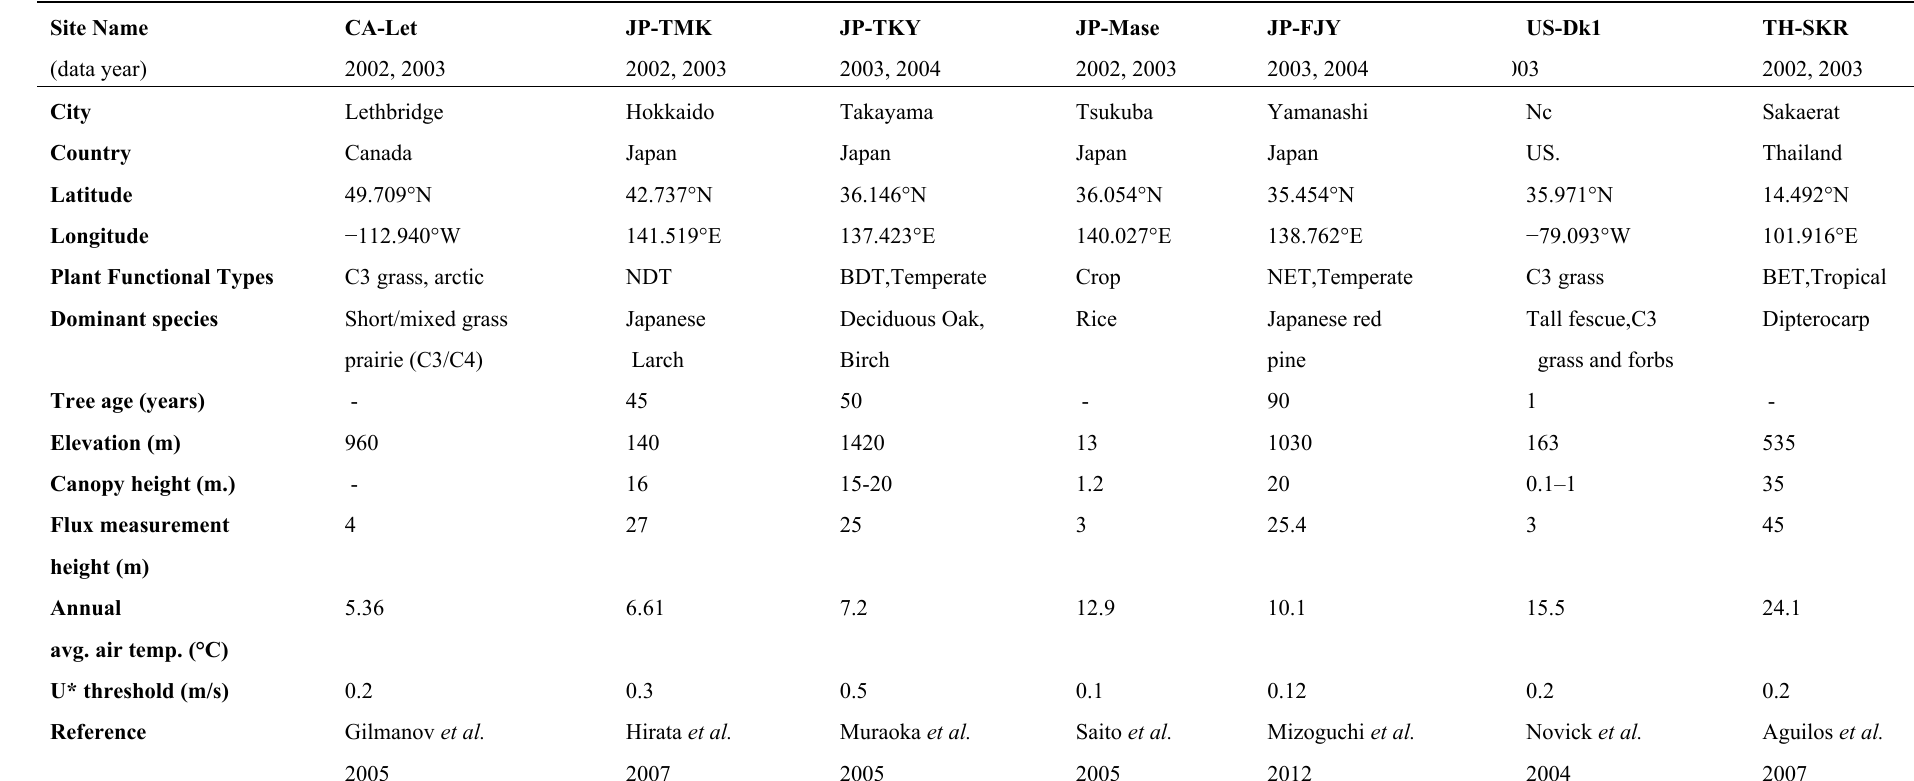
Table 2. Description of the study sites representing seven plant functional